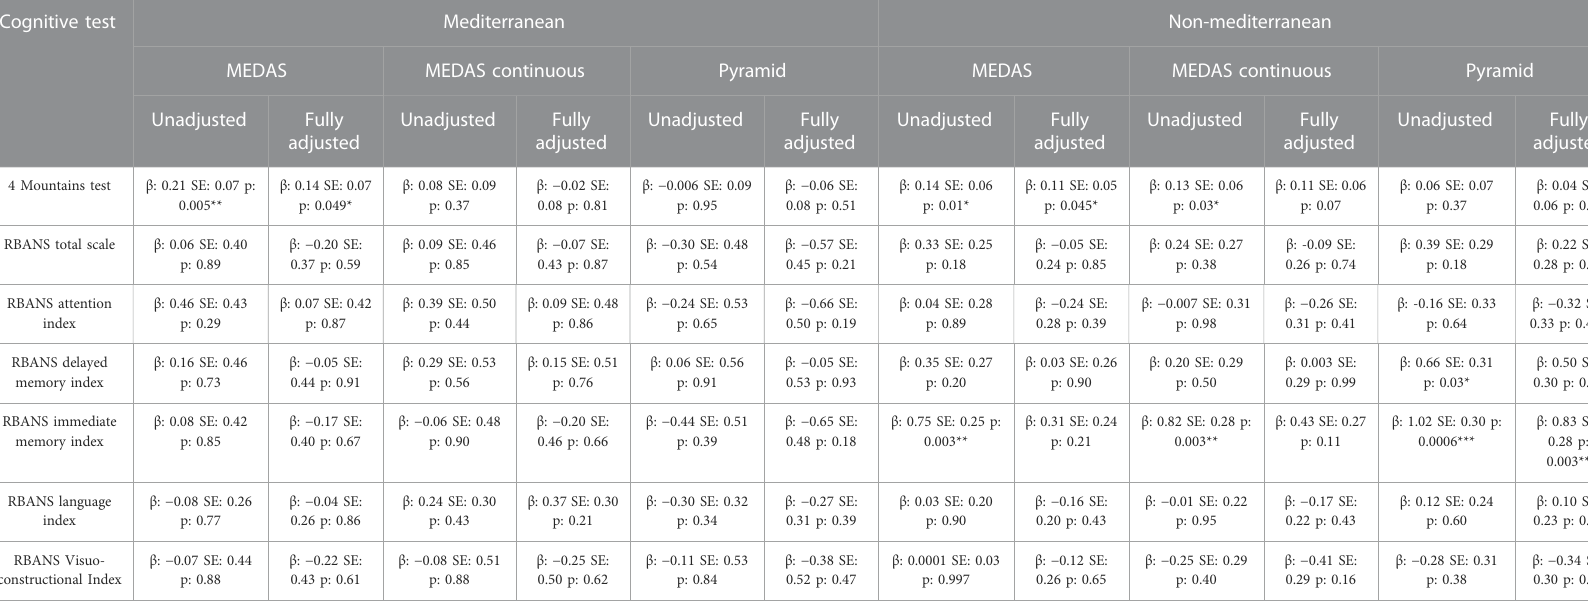
TABLE 4 Linear regression models of MedDiet scores (MEDAS, MEDAS Continuous and Pyramid) with cognitive outcomes living in Mediterranean (FMT: n = 437; RBANS: n = 609) and non-Mediterranean countries (FMT: n = 707; RBANS: n = 1,217). Unadjusted Model: MedDiet Score; Fully Adjusted Model: MedDiet Score, sex, age, education, family history, APOE, physical activity, smoking, sleep, BMI, hypertension, hypercholesterolemia, hyperglycaemia, diabetes, stroke, antihypertensive medication use, diabetic medication use. * p < 0.05; ** p < 0.01; *** p <